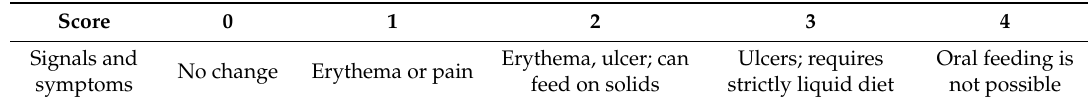
Table 1. OM classification